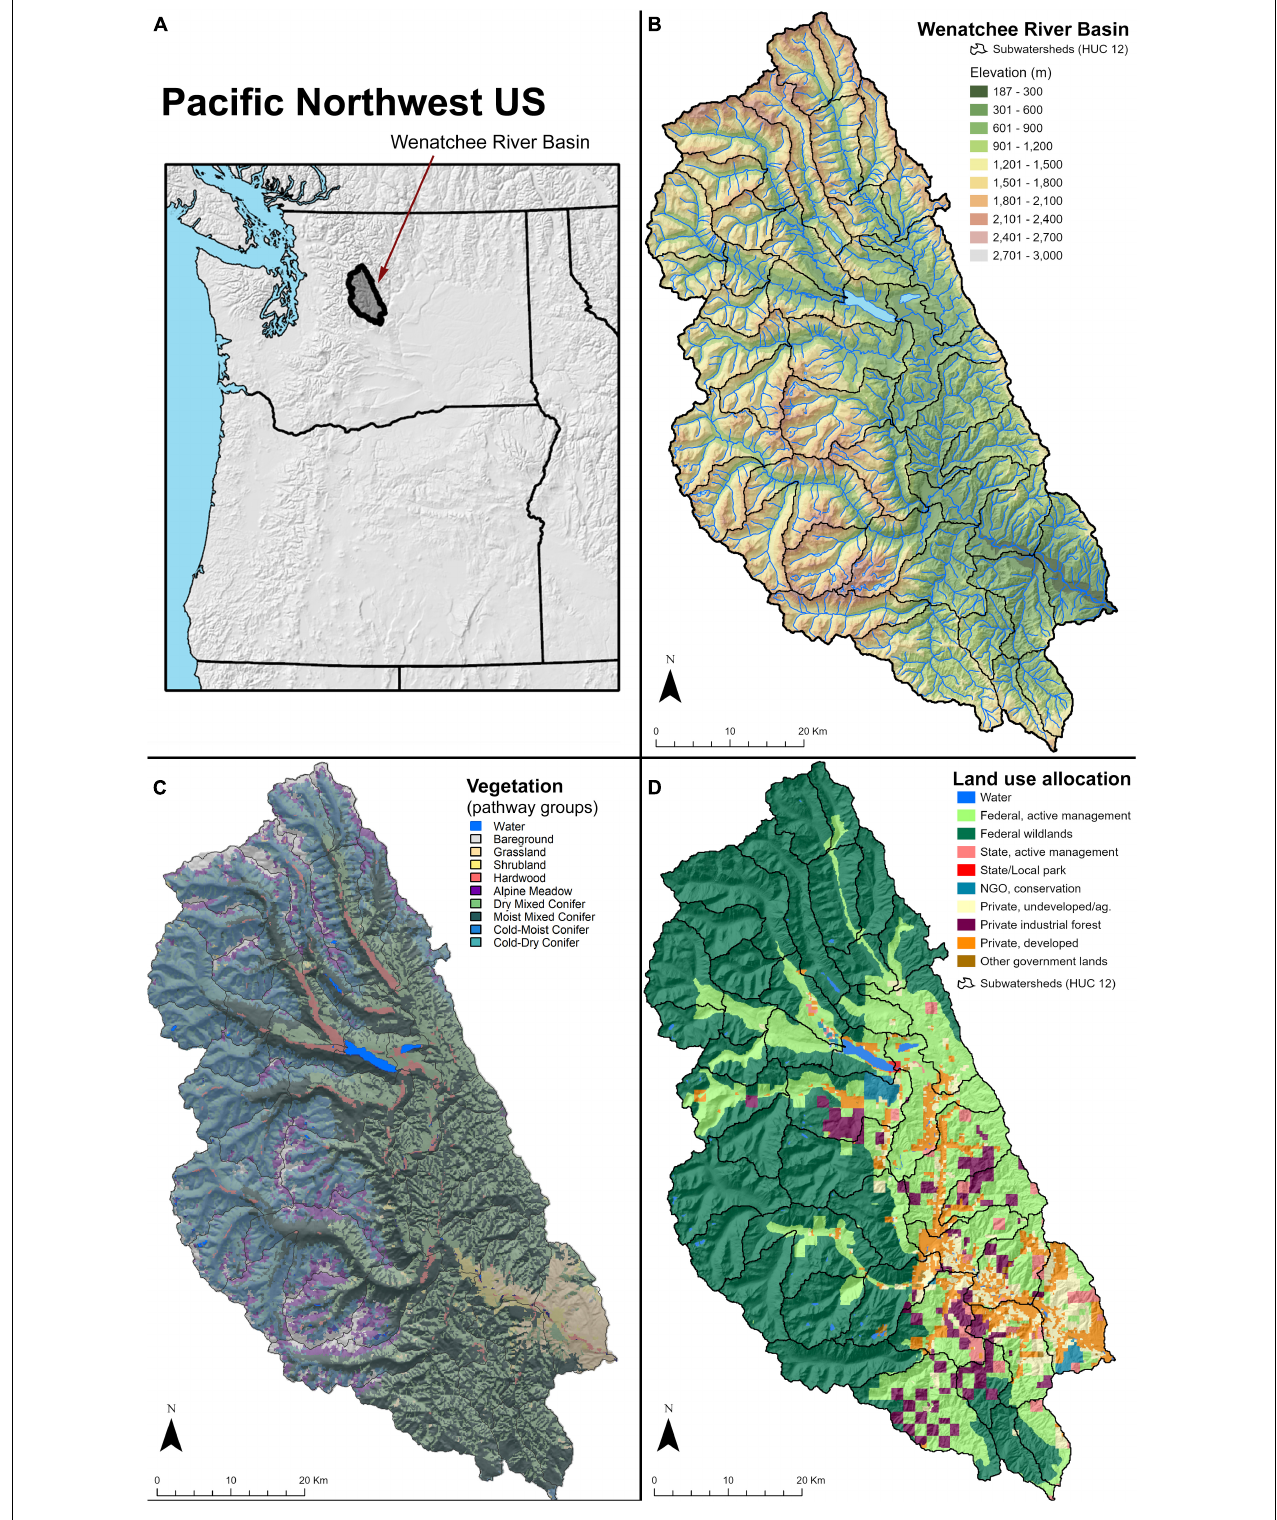
FIGURE 1 | Location of the Wenatchee River Basin in the Cascade Mountains, north-central Washington State (A) . Elevation ranges from 187 to 2,810 m (B) , giving rise to diverse vegetation communities (C) . Land ownership is mixed, with 56% designated as wilderness or roadless (D) .